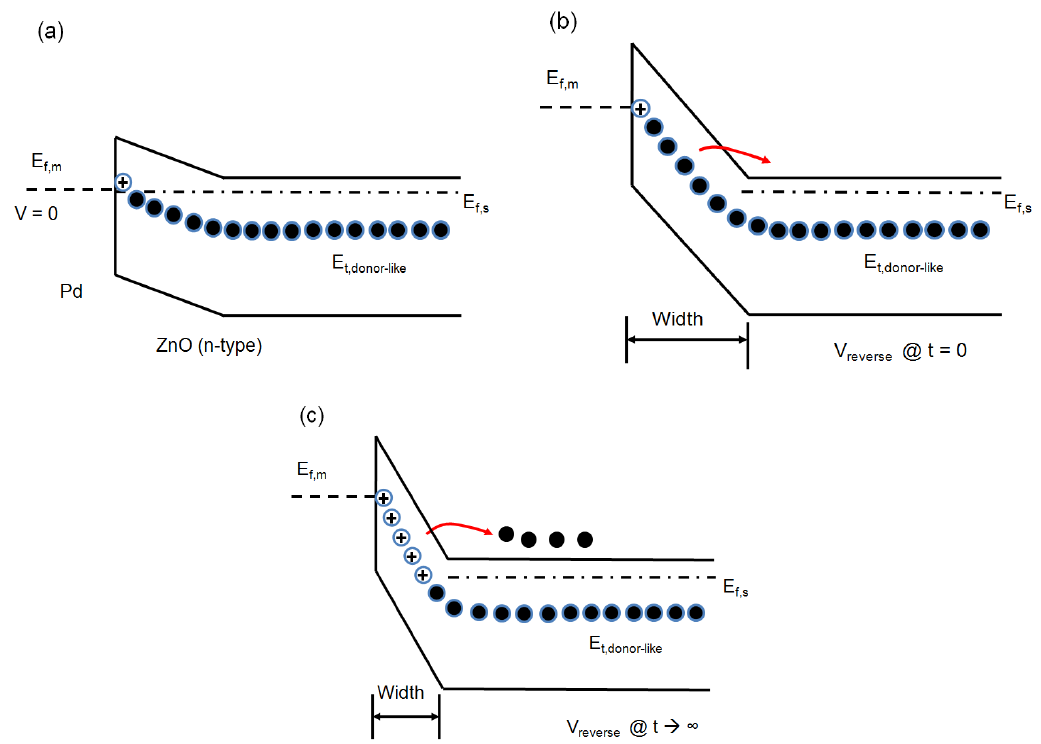
Figure 5. (Color online) A Schottky diode for majority carrier emission; ( a ) zero bias (forward bias), ( b ) reverse bias at t = 0, ( c ) reverse bias as t → ∞ .